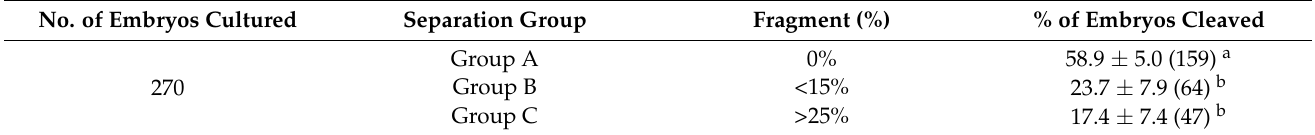
Table 1. Cleaved embryo ratios of Groups A, B, and C according to blastomere fragmentation.